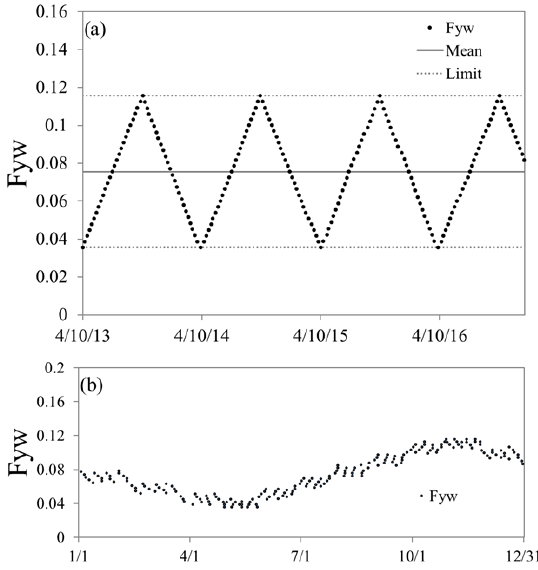
Figure 2. (a) Example of a theoretical Fyw time series, where despite the time variance, all three null hypotheses are accepted: (1) more than 90% of Fyw values lie within ± 0 . 04 of the mean of all values, (2) Fyw does not change more than ± 0 . 04 over the course of 4 weeks, and (3) Fyw for each month does not change more than ± 0 . 04 within a month (b)